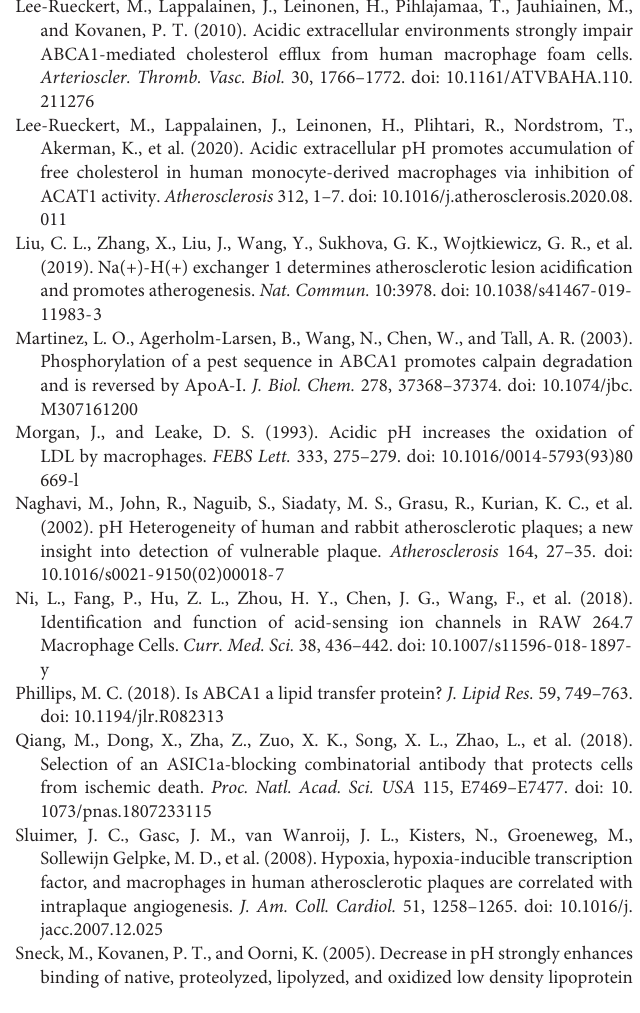
Supplementary Figure 1 | ASIC1/calpain1 has no effect on the ABCA1 mRNA level. RAW 264.7 macrophage cells were cultured in pH 6.5 medium in the absence or presence of ASIC1 specific inhibitor PcTx-1 (100 ng/ml) or calpain1 inhibitor PD150606 (50 µ M) for 24 h. The mRNA level of ABCA1 was measured using real-time PCR (RT-PCR). Data were shown as the mean ± SEM from 3 to 4 independent experiments. Statistical analysis was performed by one-way